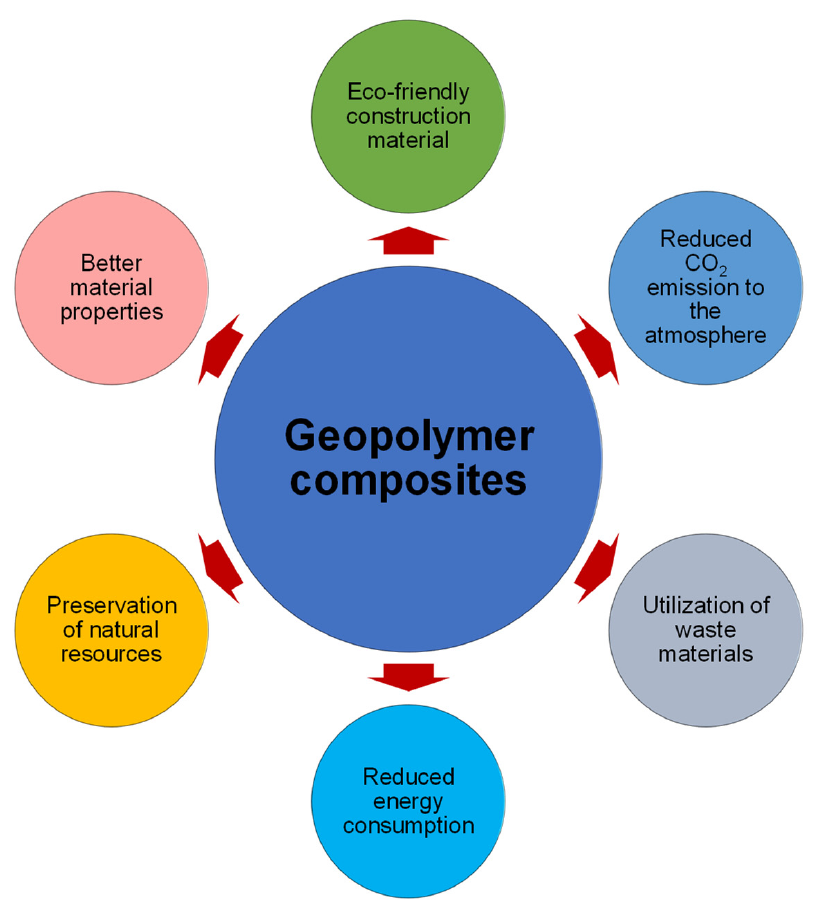
Figure 12. Advantages of geopolymer composites produced with waste materials. The ensembled ML algorithms commonly exploit the weak learner by generating sub- models that may be trained on data and adjusted to optimize the R 2 value. The dispersion of R 2 values for the AdaBoost and RF sub-models is shown in Figure 13. The minimum, average, and highest R 2 values for AdaBoost sub-models were 0.854, 0.876, and 0.900, respectively. Similarly, the minimum, average, and highest R 2 values for RF sub-models were 0.872, 0.892, and 0.900, respectively. These results demonstrate that both the AdaBoost and RF sub-models have comparable values and a high degree of precision in forecasting GPC’s CS. Additionally, a sensitivity analysis was done to ascertain the effect of all inputs on the expected CS of GPC. The model’s performance might be affected by the input parameters and the dataset’s size. The sensitivity analysis determined how each of the nine input characteristics contributed to the projected output. Fly ash, GGBS, and NaOH molarity were determined to be the three most significant input